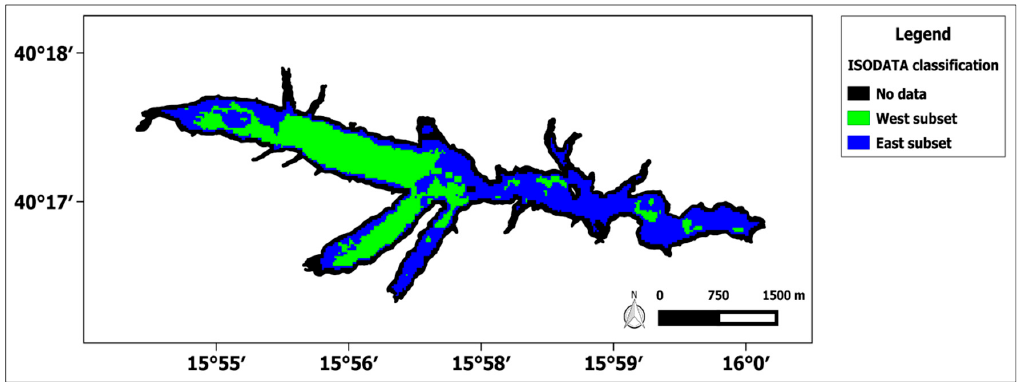
Figure 10. Map resulting from the ISODATA (Iterative Self-Organizing Data Analysis technique) non-supervised classification.